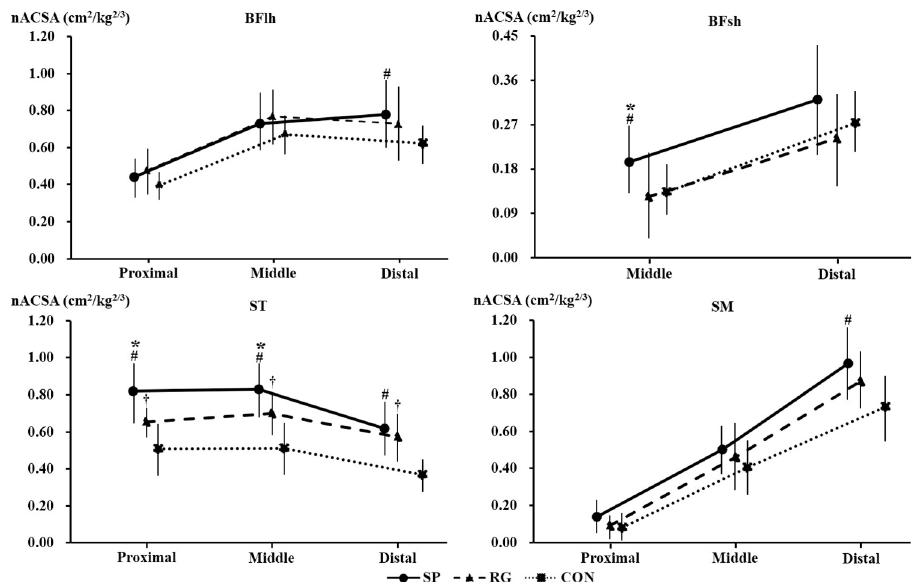
Fig 4. The normalized anatomical cross-sectional area in each region of the biceps femoris long head (BFlh), the biceps femoris short head (BFsh), the semitendinosus (ST), and the semimembranosus (SM) in the sprinters (SP), rugby players (RG), and non-athletes (CON). � Significant difference between the sprinters and the rugby players. #Significant difference between the sprinters and the non-athletes. †Significant difference between the rugby players and the